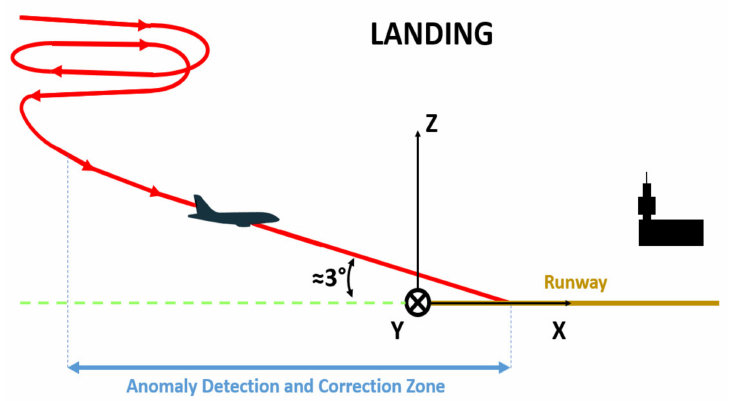
Figure 1. Anomaly detection and correction zone during the landing of an